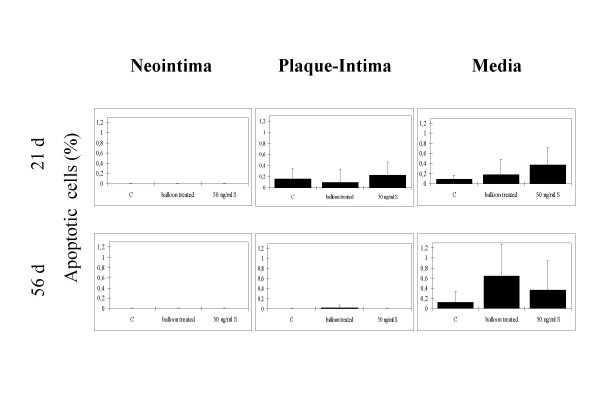
The effect of incubation of the ex vivo HOC-model with SRL (50 ng/ml) on apoptosis was studied in the neointima, plaque-intima, and media at day 21 and day 56.